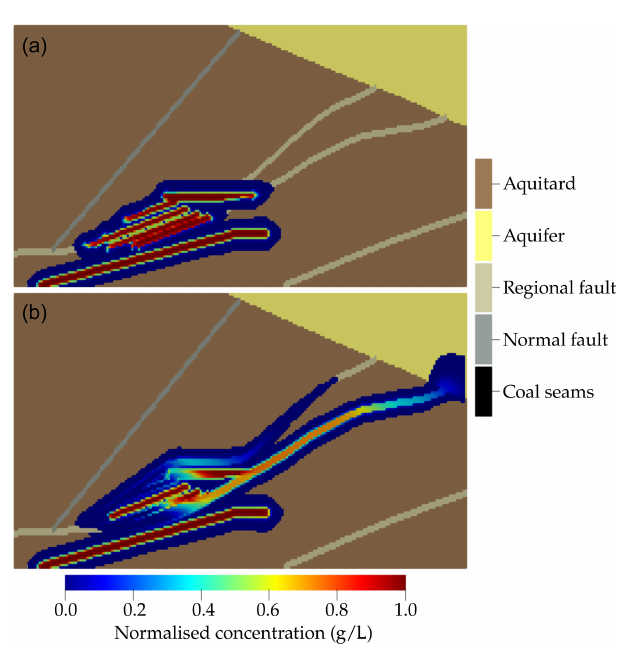
Figure 6. Concentration distribution after 50 years for (a) minimum and (b) maximum hydraulic conductivity of the regional